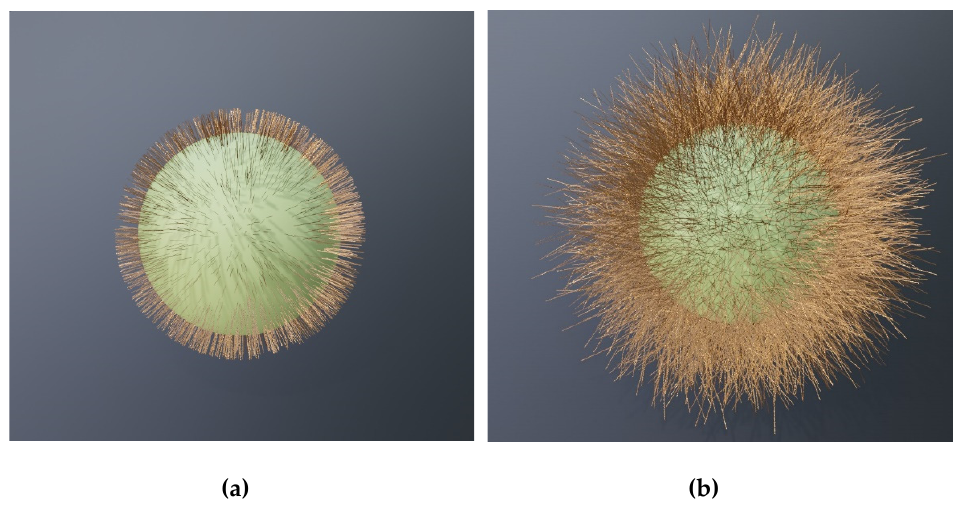
Figure 7. Brochosome-inspired microspheres with metal nanowires grown on the dielectric shell surface; ( a ) vertically grown cylindrical metal nanopillars; ( b ) disordered metal